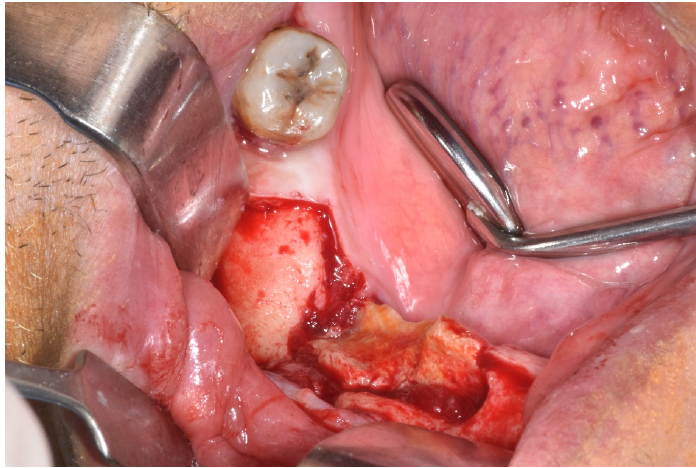
Figure 3. Intraoperative situation with necrotic bone sequestrum. Int. J. Environ. Res. Public Health 2020 , 17 , x FOR PEER REVIEW